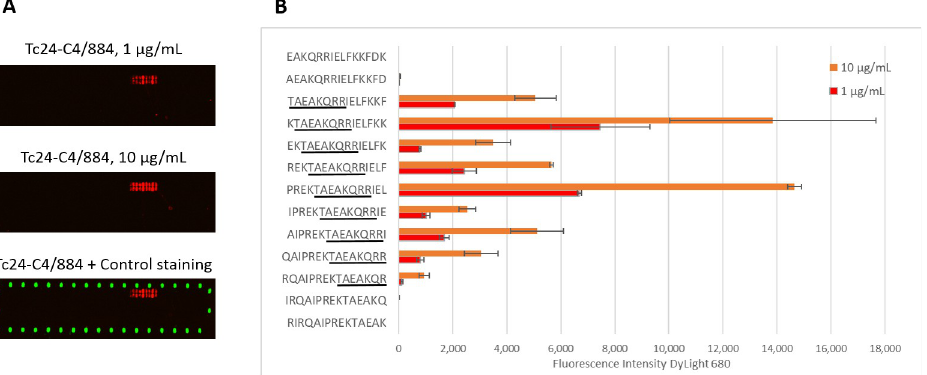
Fig 2. Linear epitope mapping of monoclonal antibody Tc24-C4/884. A) Scan of the microarray showing an increased intensity of DyLight 680 (red) in a stretch of adjacent peptide sequences when 1 and 10 μ g/mL Tc24-C4/884 was used. DyLight 800 was used as a positive control (green). B) Measured median Fluorescent Intensity of DyLight 680 plotted with their corresponding peptide sequences. The consensus sequence is underlined in black.